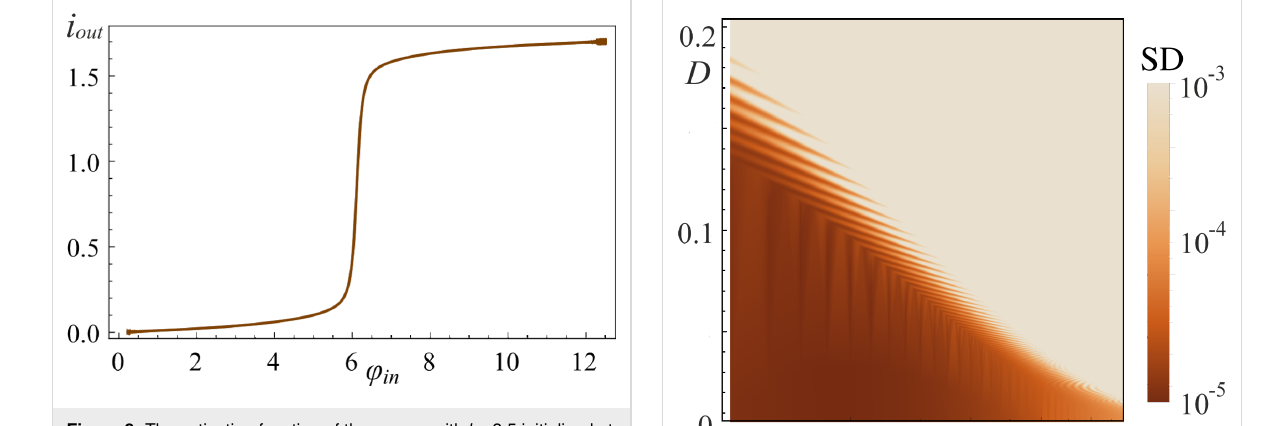
Figure 8: The activation function of the neuron with l = 2.5 initialised at t = 0 in the ground state. Here the parameters are D = 0.0002, A = 4 π , and t 1 = 10000.